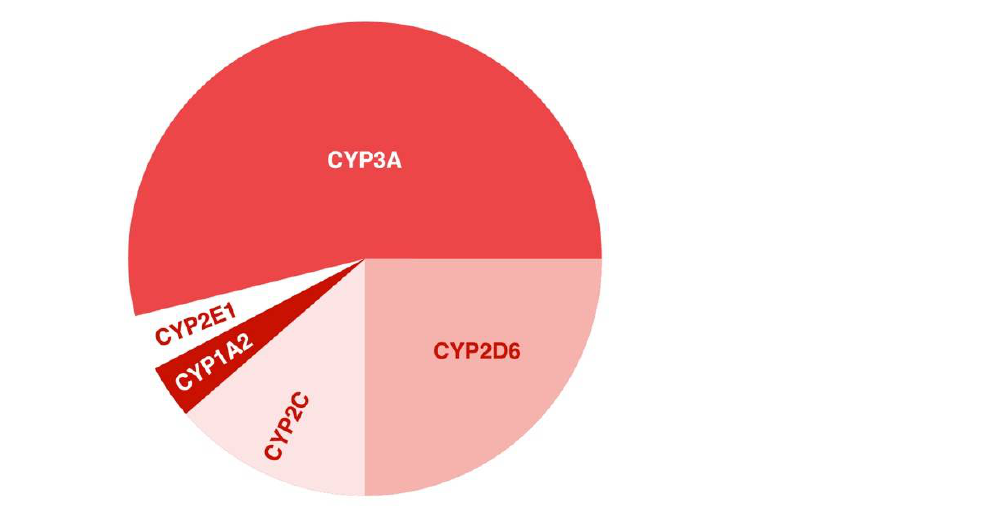
Figure 2. Estimated percentage of antipsychotics metabolized by the major cytochrome P450 enzymes ([31], modified by the authors).